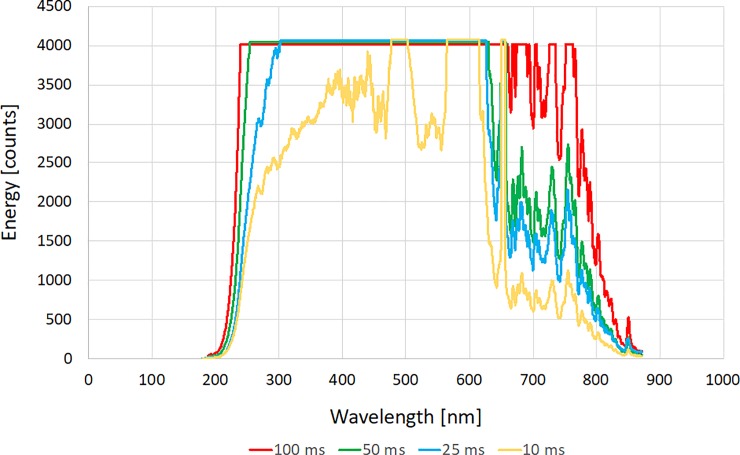
Transmission spectra recorded for UAM UV-vis cell at varying acquisitions times (10–100 ms).